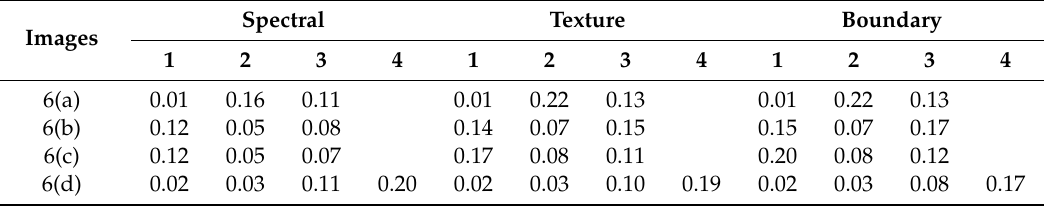
Figure 10. Changes of features’ weight values for all the classes: ( a1 – a4 ) Feature 1, ( b1 – b4 ) feature 2, ( c1 – c4 ) feature 3. Table 5. Approximate feature weight values for real SAR